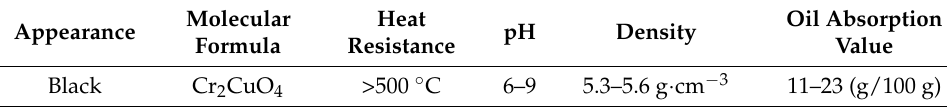
Table 3. The technical characteristics of copper chromite black